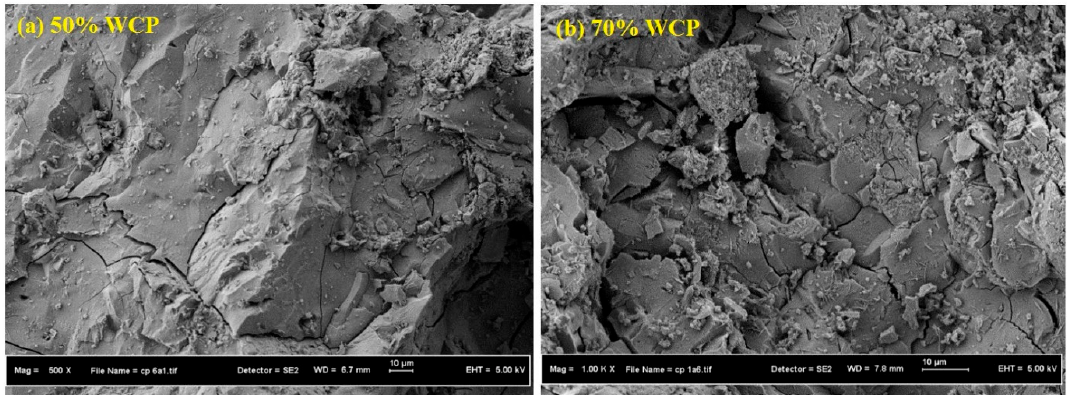
Figure 10. SEM images of AAM designs with ( a ) 50% and ( b ) 70% ceramic contents.